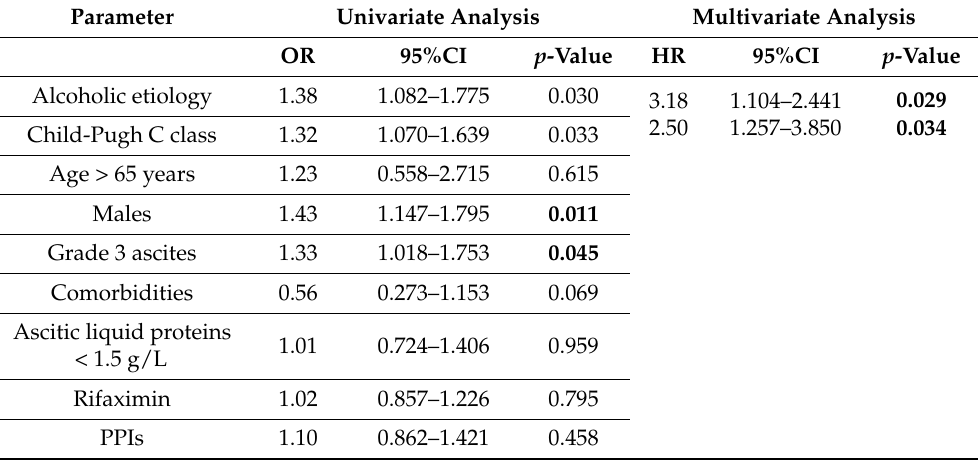
Table 2. Risk factors for CDI—univariate and multivariate